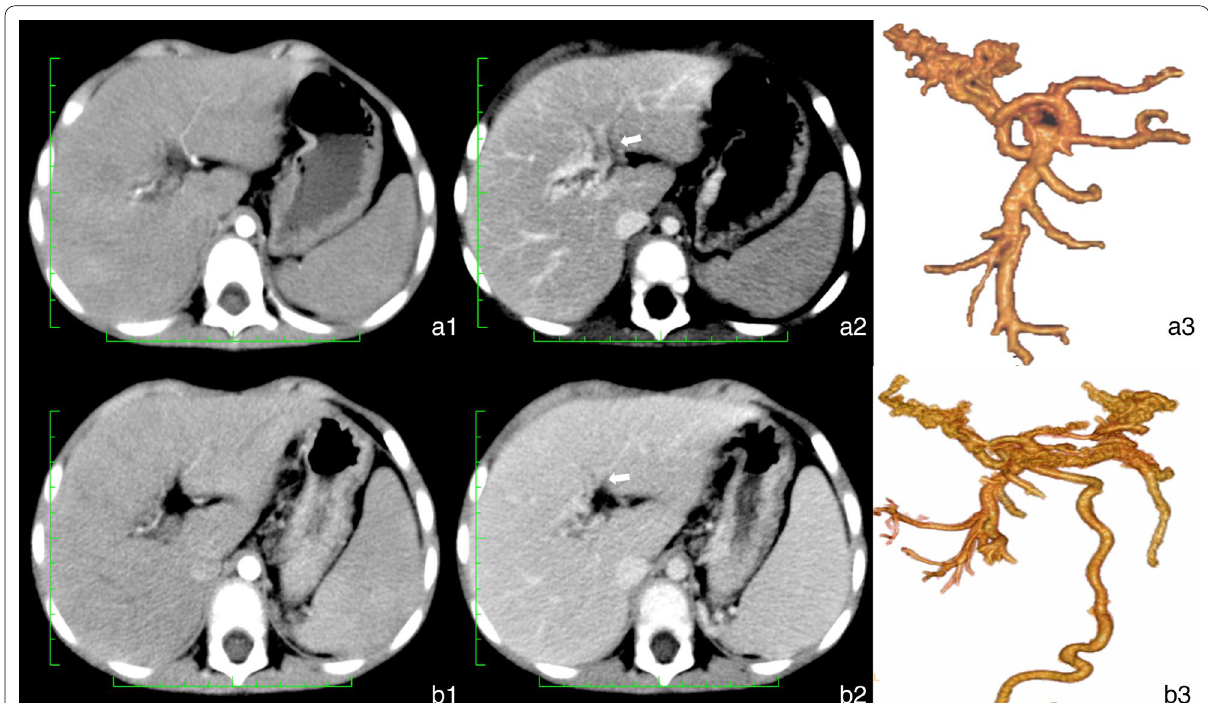
Fig. 6 Male patient aged 2 years 6 months with a 6-month history of black stool. a The Rex recess was faintly visible and the diameter of the Rex recess (white arrow) was 1.8 mm (type 3). b Computed tomography angiography after 18 months. Complete loss of vascular landmarks of the Rex recess (white arrow), which was type 4. b3 Volume rendering showed an increase in cavernous transformation